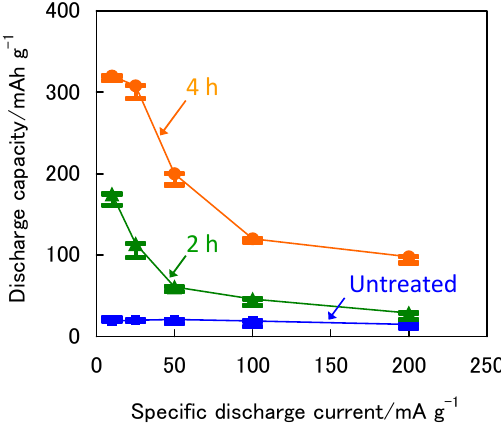
Figure 3. The initial capacities as a function of specific discharge current at 333 K for the ZrNi electrodes with and without the boiling alkaline treatment for 2 h and 4 h.